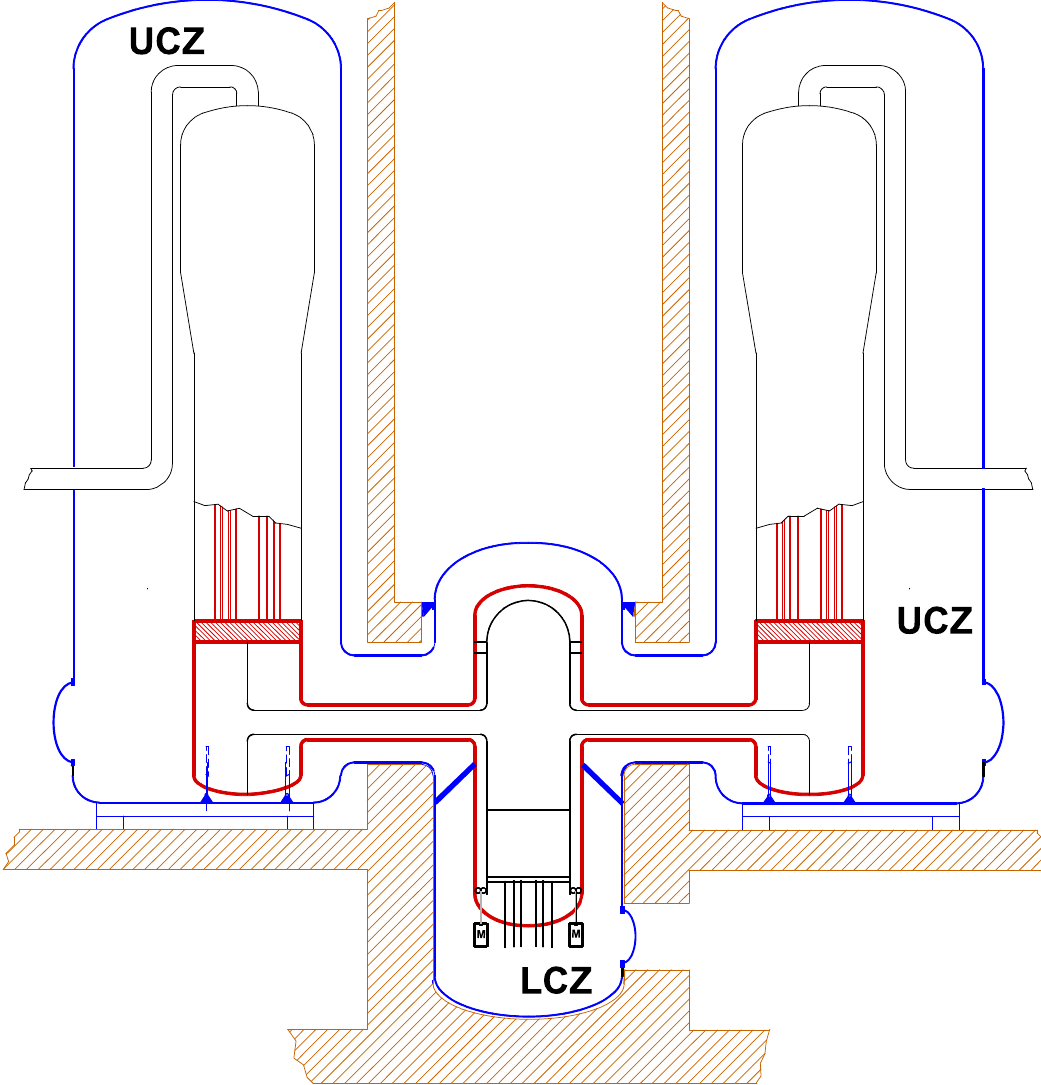
Fig. 2. Two-zone, small volume, high pressure containment. The containment is partitioned into two separate leak tight zones: LCZ the Lower Containment Zone, consisting of the reactor cavity below the RPV, and containing the RCP ’ s mounted on the RPV bottom, and other equipment, not shown (e.g. shielding, instrumentation). Free volume of the LCZ is approx. 230 cubic meters. UCZ the Upper Containment Zone, comprising the region surrounding the upper part of the RPV and the two Steam Generator (SG) compartments. Free volume of the UCZ is at least 4500 cubic meters. The free volume in the lower part of the UCZ, that is, below the level of the RCS main piping connections, is approx. 700 cubic meters. Maximum pressure for both LCZ and UCZ is close to 20 bars. Four containment access openings include the containment dome above the RPV, and access ports for the LCZ (reactor cavity), and for the SG